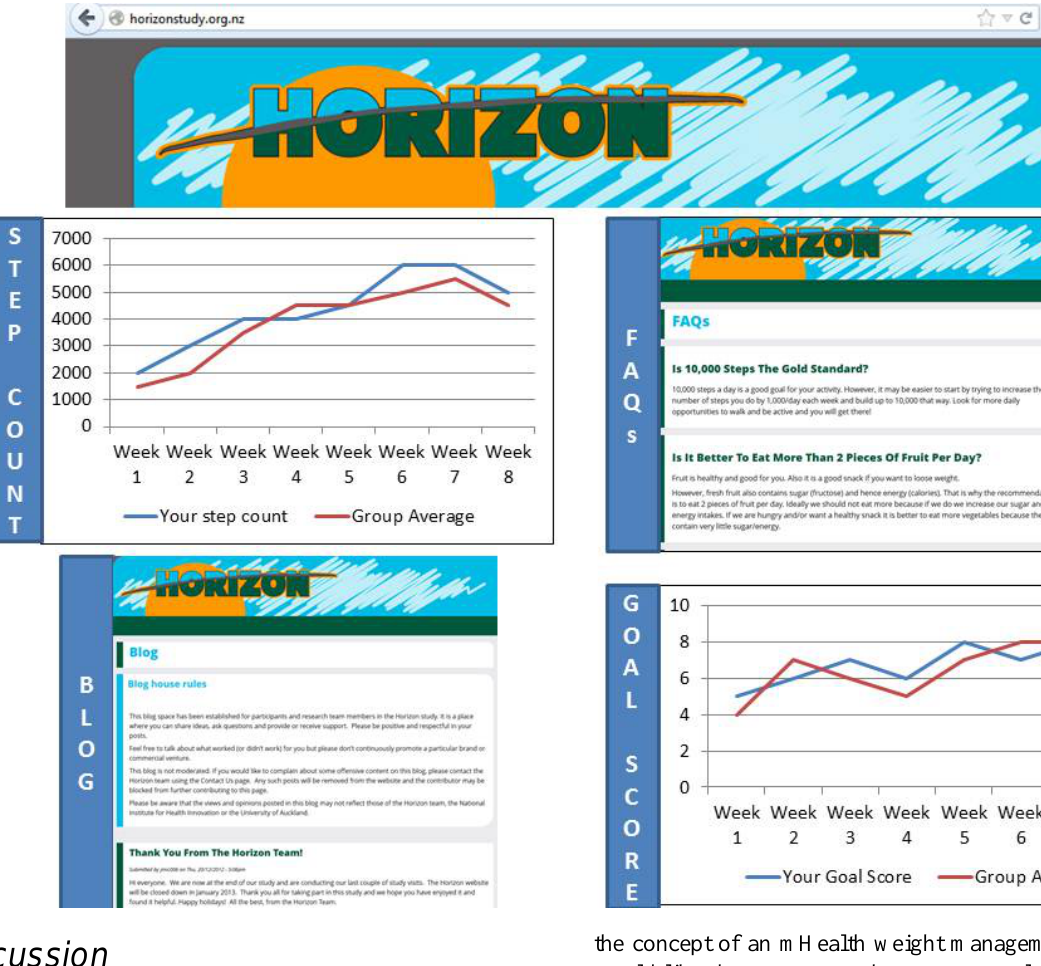
Figure 2. Horizon